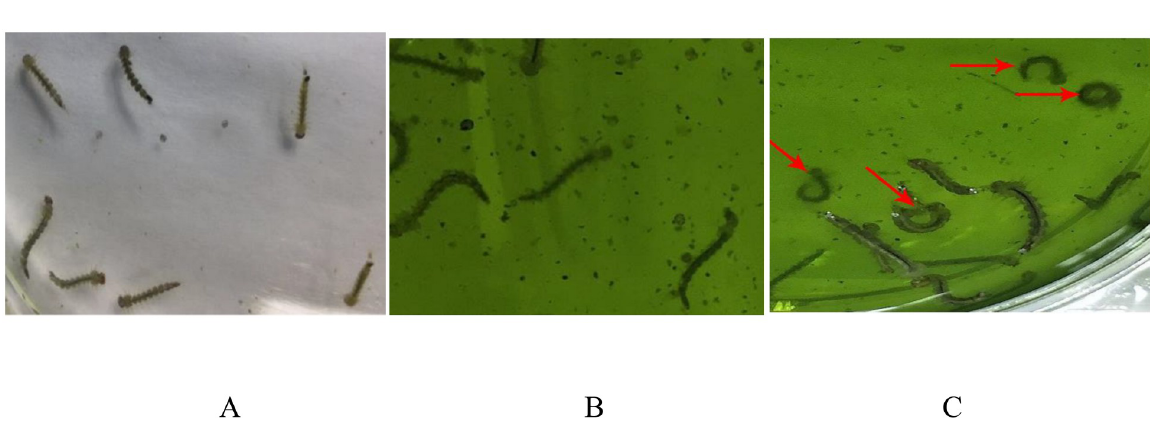
Fig 3. The growth status of Aedes aegypti larvae fed with pMaa7IR/HR3IR transgenic algae. A, Aedes larvae fed with fodder. B, Aedes larvae fed with non-transgenic C. reinharditii strain CC425. C, Aedes larva fed with pMaa7IR/HR3IR transgenic algae strain HR3-C9. The arrow points to the Aedes bit its anal fistula. The larvae bit their anal fistula in the early stage before death. Their bodies were floating on the water surface and trembling with active movements. In the late stage, their bodies were inactive and eventually sank into the water (C). The control group (larvae fed with non-transgenic C. reinhardtii CC425 and fodder) had stable growth with no biting and active movement (A, B).